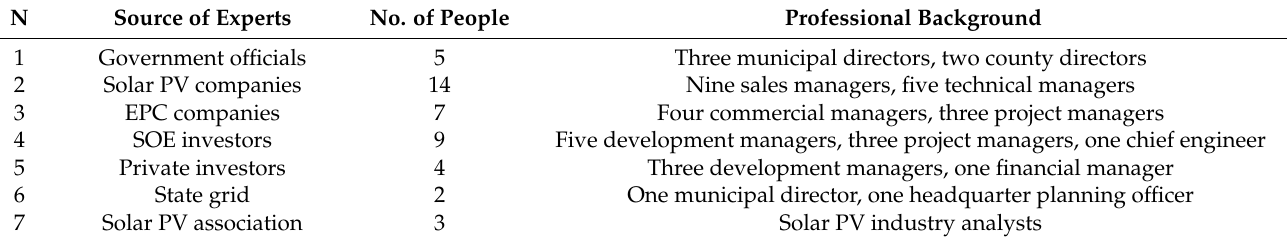
Table 1. Profiles of the